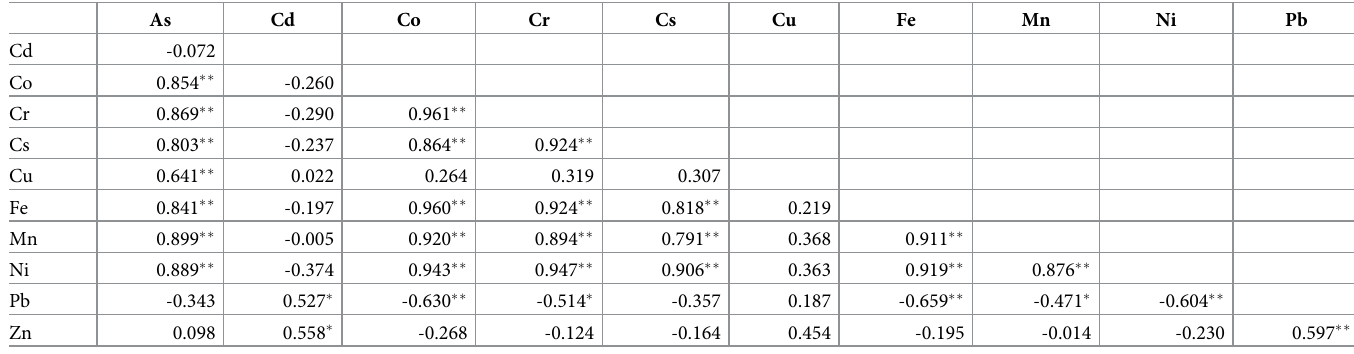
Table 3. Pearson correlation coefficient matrix for heavy metal concentrations in the urban soil